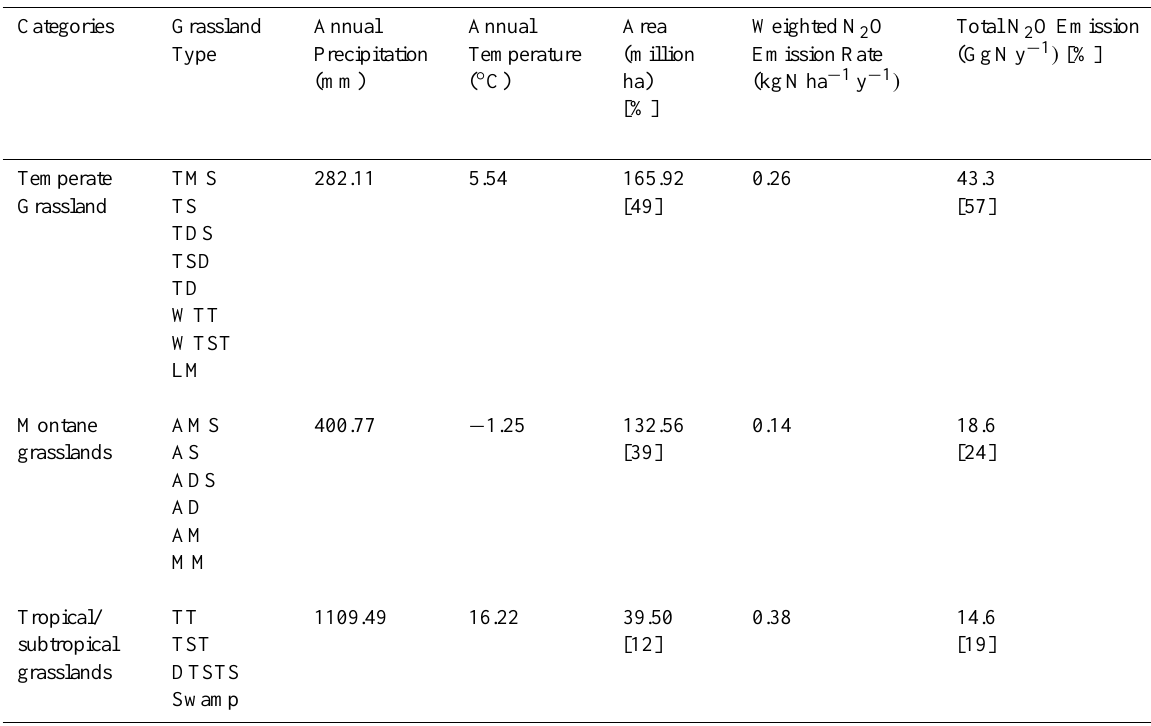
Table 4. Grassland categories, zonal climate and average N 2 O flux. The weighted emission rates were calculated by category total emission 736 divided by category total